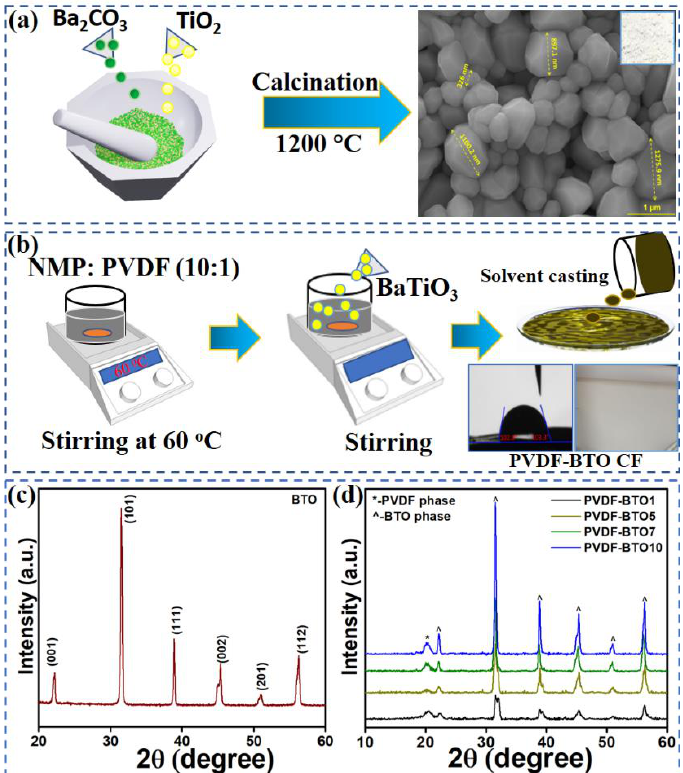
Figure 1. Synthesis of particle and piezoelectric nanogenerator; ( a ) BaTiO 3 particles by solid-state reaction method and surface morphology of the polycrystalline particles; ( b ) the solvent casting route and systematic steps for formation of the PVDF-BTO composite film, the contact angle of the composite film showing hydrophobic nature of their surfaces; ( c ) XRD pattern of the BaTiO 3 parti- cles and ( d ) shows the XRD pattern of the PVDF-BaTiO 3 composite films at different wt% of particles (1, 5, 7, 10 wt%) into the PVDF matrix.